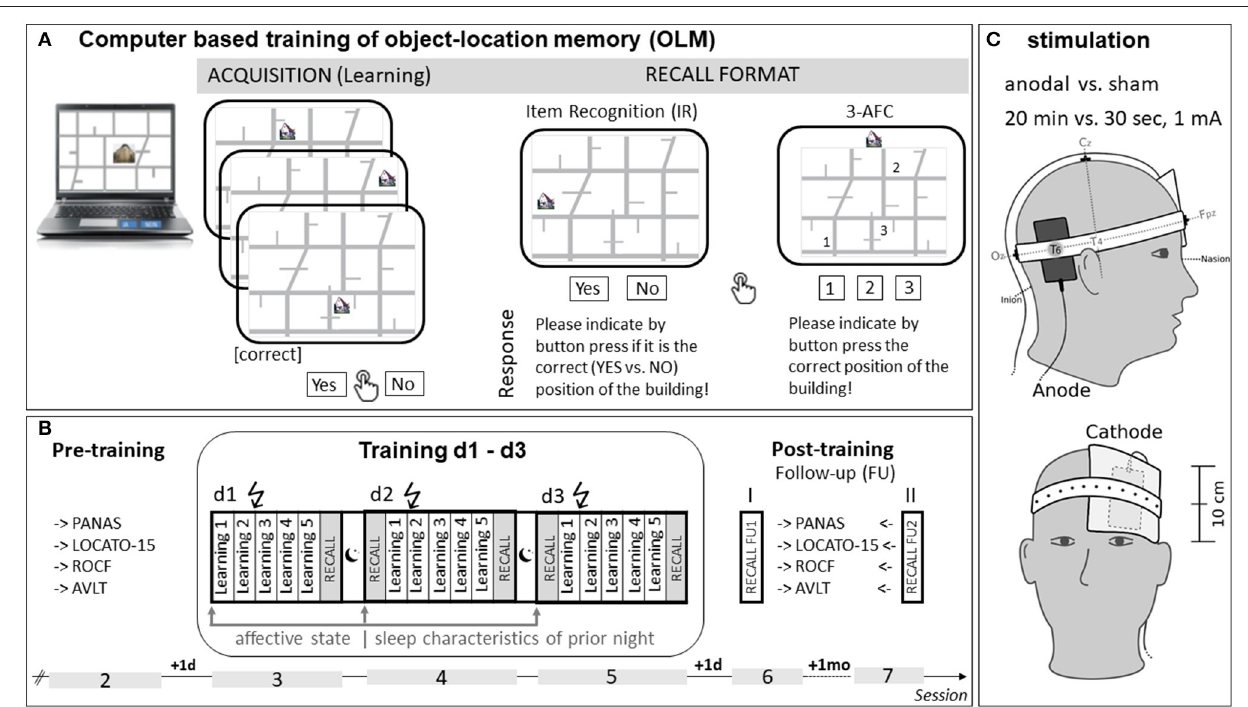
FIGURE 1 | Study overview. (A) Schematic of the associative object-location learning paradigm (LOCATO). During acquisition, each trial comprised a picture of a schematized street map with one building. Buildings (objects) occurred on one correct and 10 incorrect positions (locations). Subjects had to learn correct object-location-pairings over the course of multiple learning blocks and indicate (button press) in each trial, whether a building was in a “correct” location (Yes or NO). Memory for object-location-associations were assessed by two different cued recall tests [item recognition (IR), 3-alternative-forced choice test (3-AFC)]. During IR correct object-location-associations were intermixed with new (incorrect) object-location associations and subjects indicated by button press if presented position is “correct.” In 3-AFC tests subjects specified by button press (“1,” “2,” or “3”) the correct position of the building shown above the schematic street map. (B)